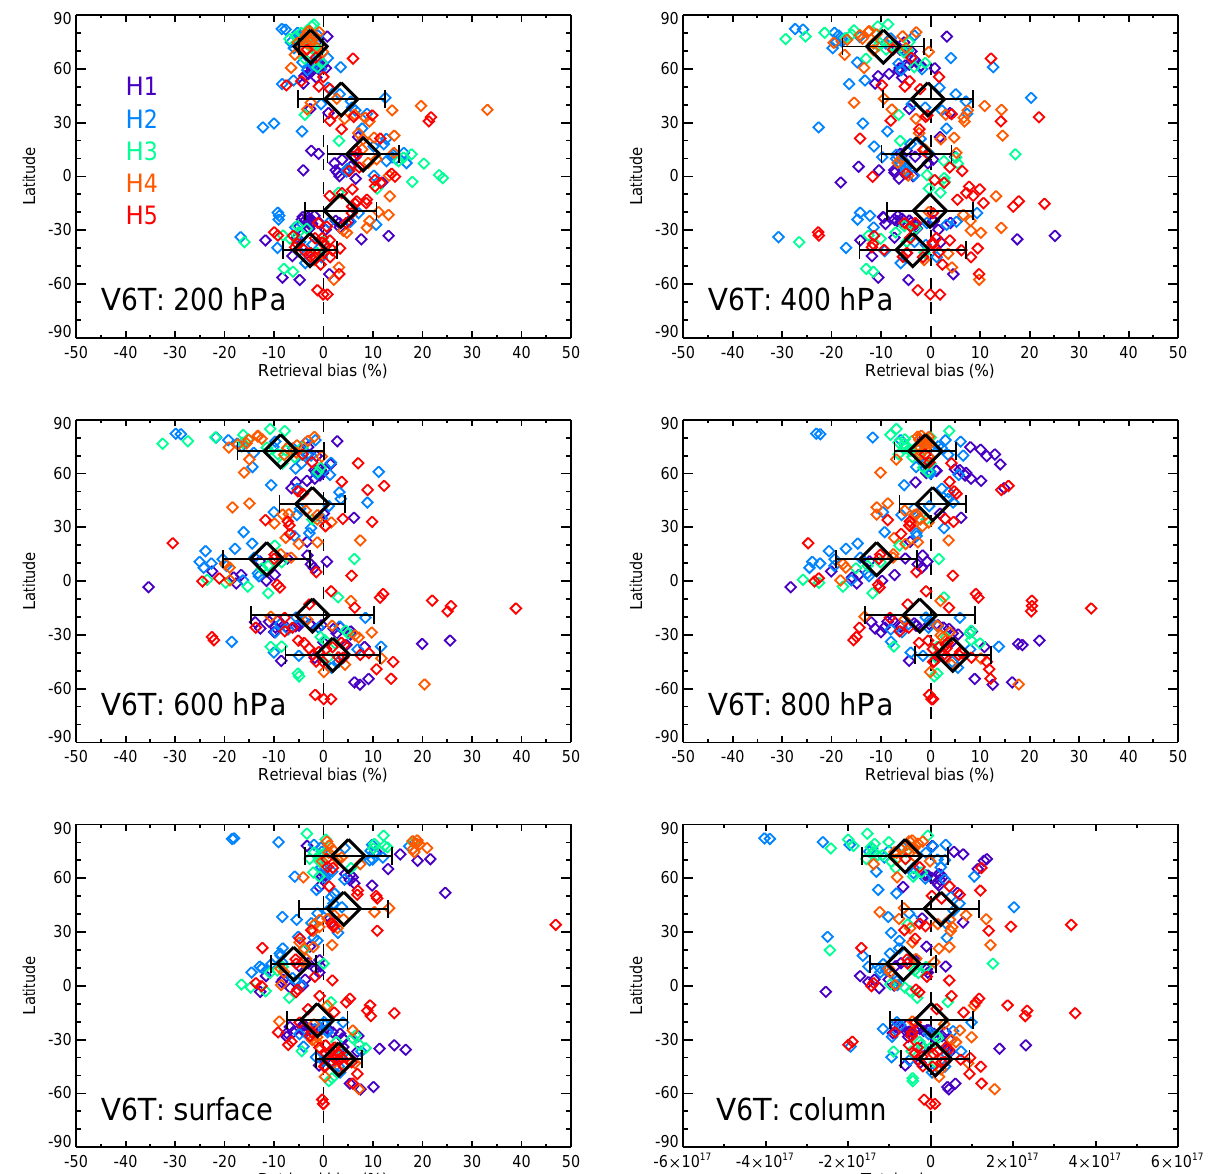
Figure 17. Latitude dependence of V6 TIR-only biases based on the HIPPO CO profiles. Large black diamonds and error bars in each panel indicate bias statistics (mean and standard deviation) representing each 30 ◦ -wide latitudinal zone. Total column error is given in units of moleccm − 2